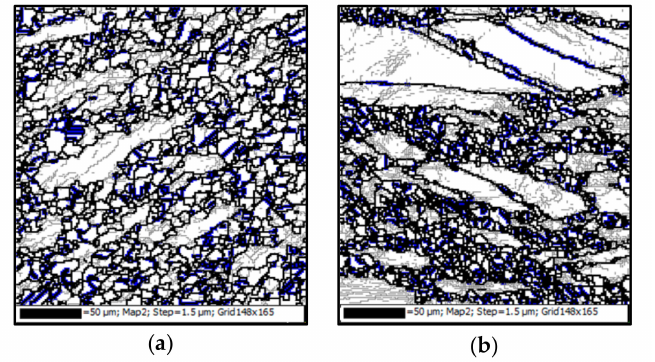
Figure 8. Evolution of annealing twins at the strain rates of: ( a ) 0.001 s − 1 ; ( b ) 0.1 s − 1 (LAGBs, HAGBs and annealing twin boundaries are indicated by thin-gray, thick-black, and thick- blue lines, respectively. The strain and the deformation temperature are 1.2 and 1253 K,